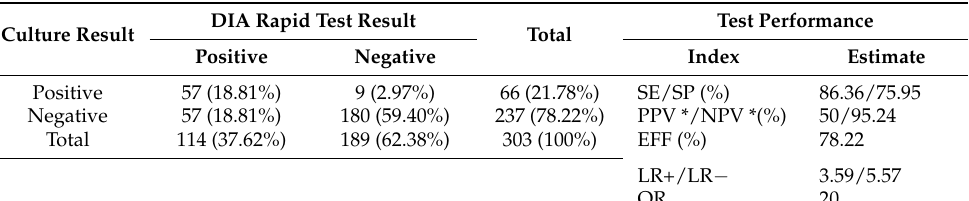
Table 1. Test performance. Contingency tables comparing the results of the DIA rapid test for anti- Scedosporium / Lomentospora specific IgG and result of sputum culture for Scedosporium / Lomentospora of 303 CF samples. Test validation parameters of performance, index and estimate.